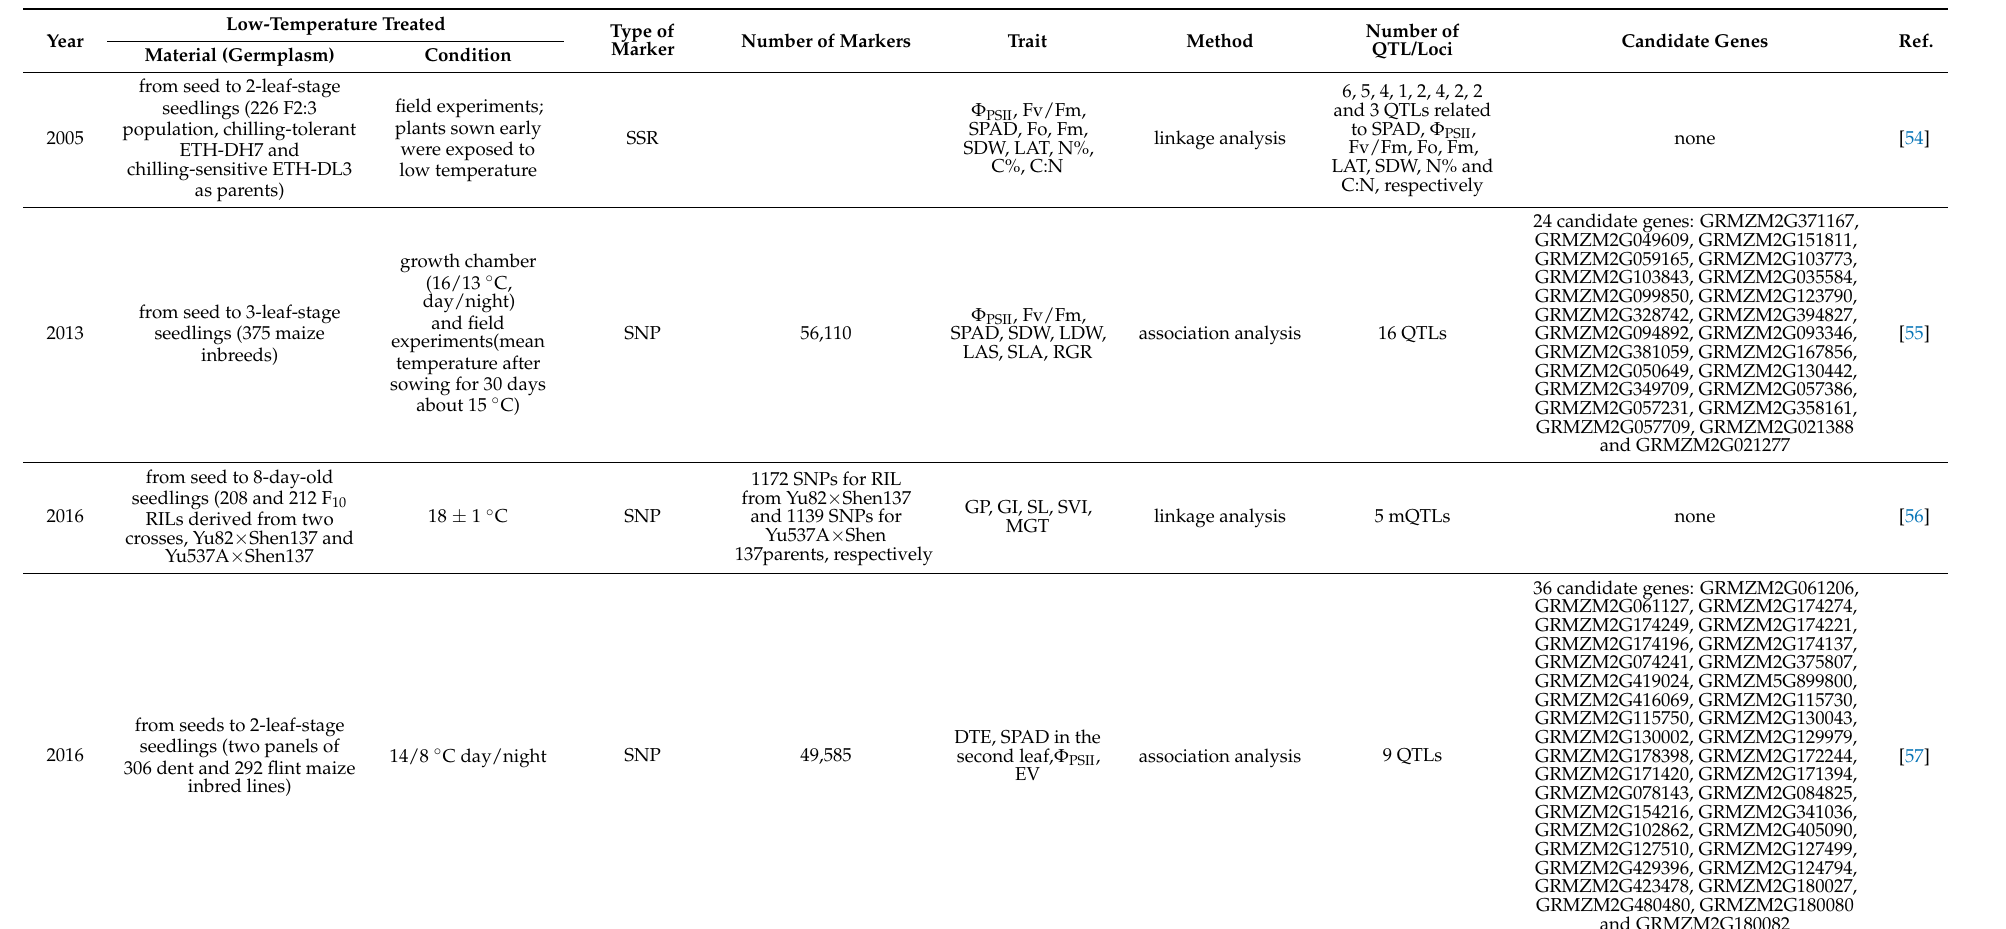
Table 2. Identification of QTLs/genes underlying